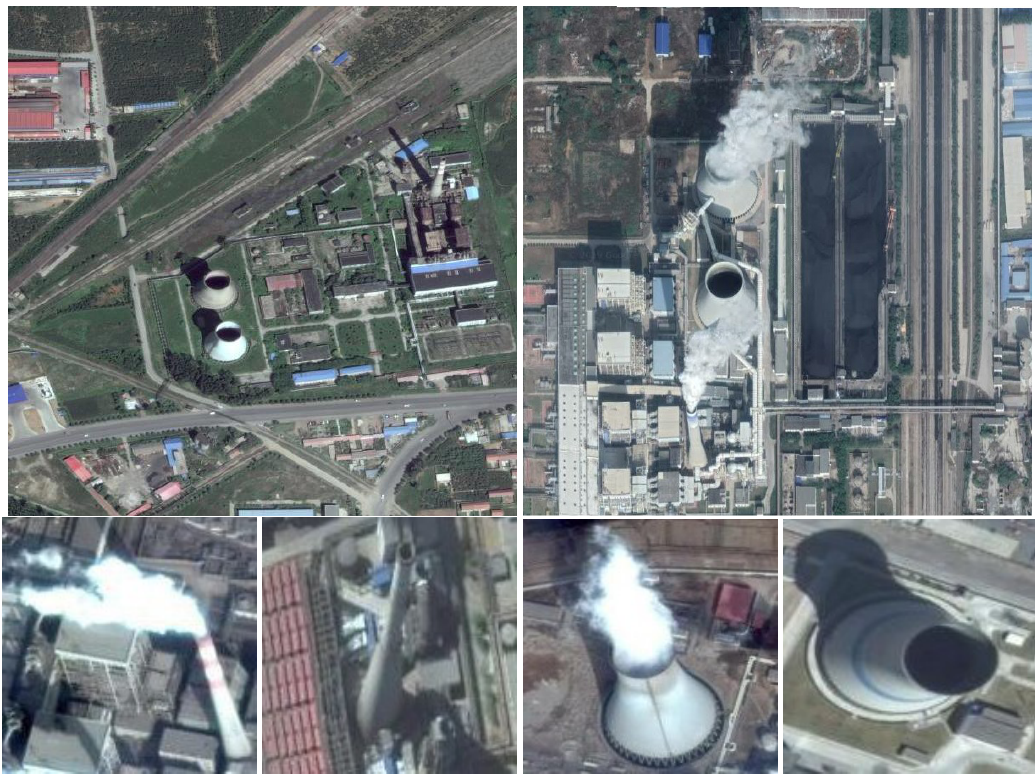
Figure 9. RSI samples in BUAA-FFPP60 dataset. The first two rows show RSIs. The last row shows cropped targets, where the columns from left to right represent working chimneys, non-working chimneys, working condensing towers and non-working condensing towers,